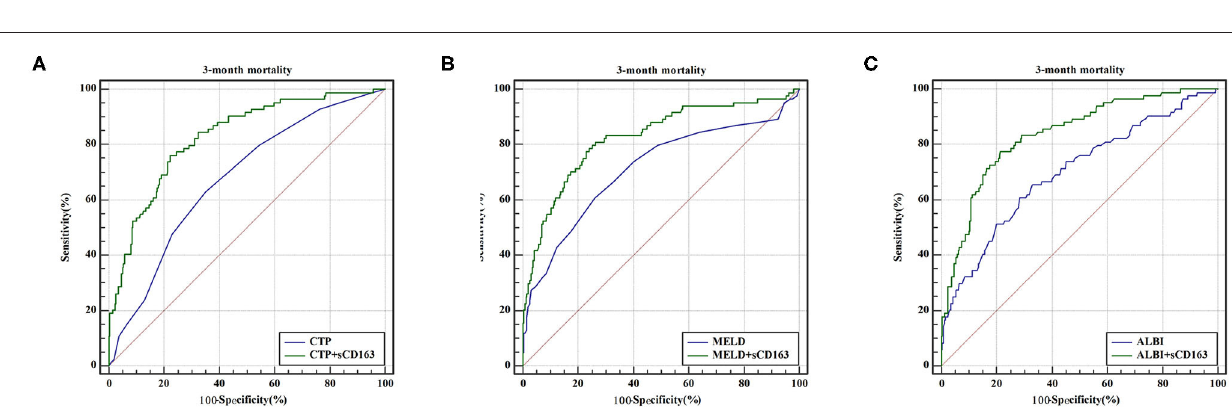
FIGURE 4 | ROC curve analysis and comparison between new scores and original scores for predicting 3-month mortality (A) ROC for CTP and CTP + sCD163; (B) ROC for MELD and MELD + sCD163; (C) ROC for ALBI and ALBI + sCD163.